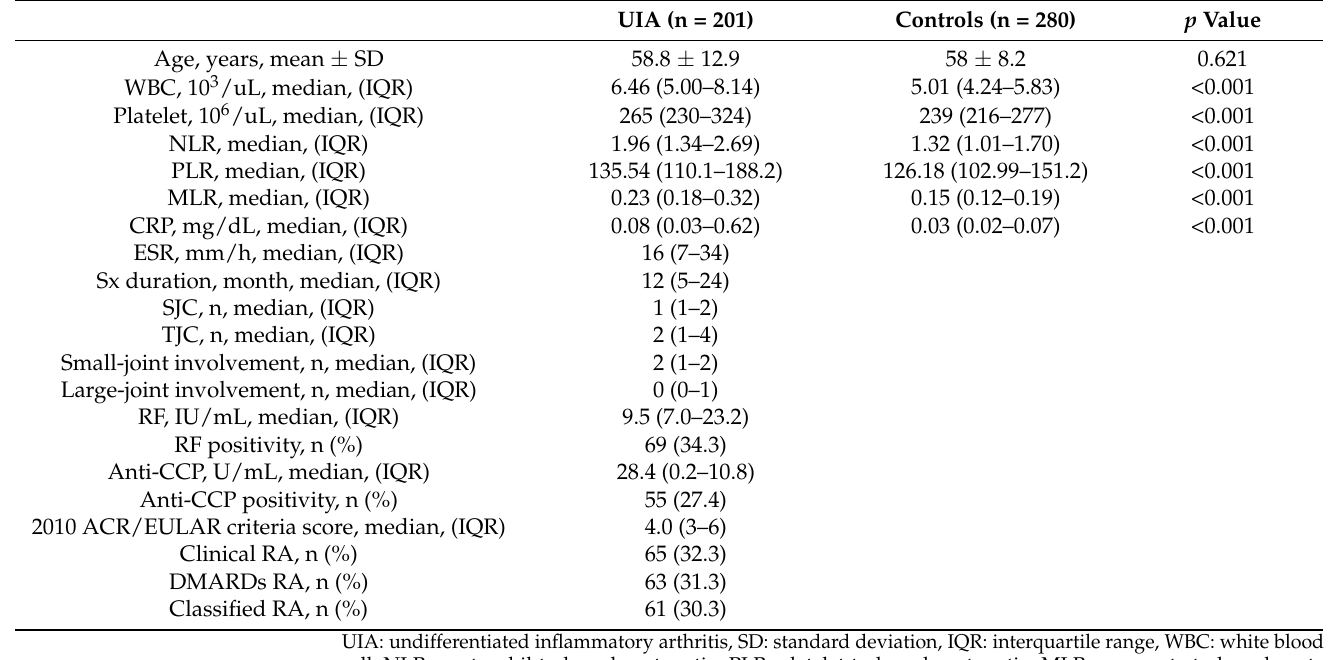
Table 1. Baseline clinical characteristics between patients with early inflammatory arthritis and healthy controls.